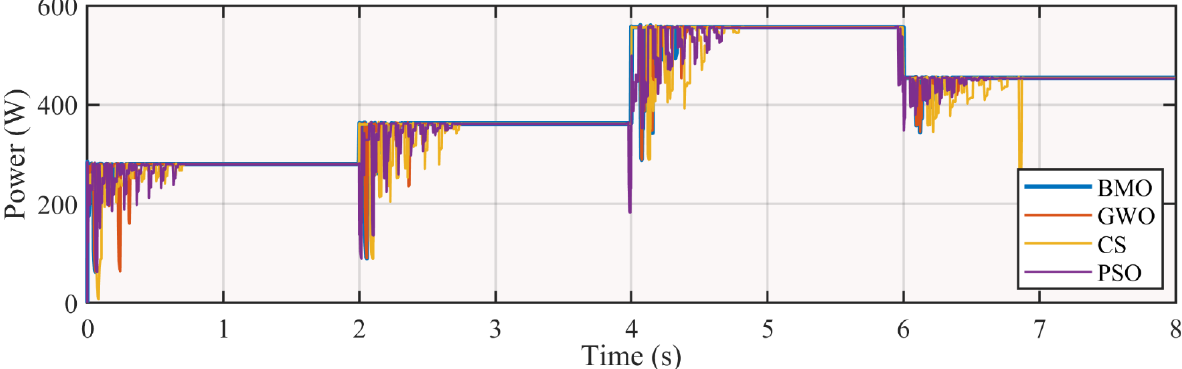
Figure 16. Competing techniques power Case-2.